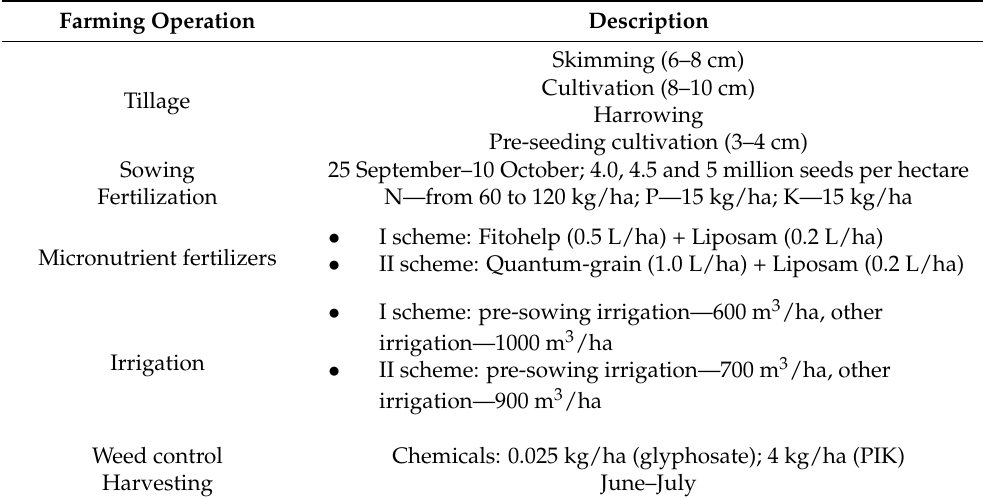
Table 1. Production of winter wheat. Farming